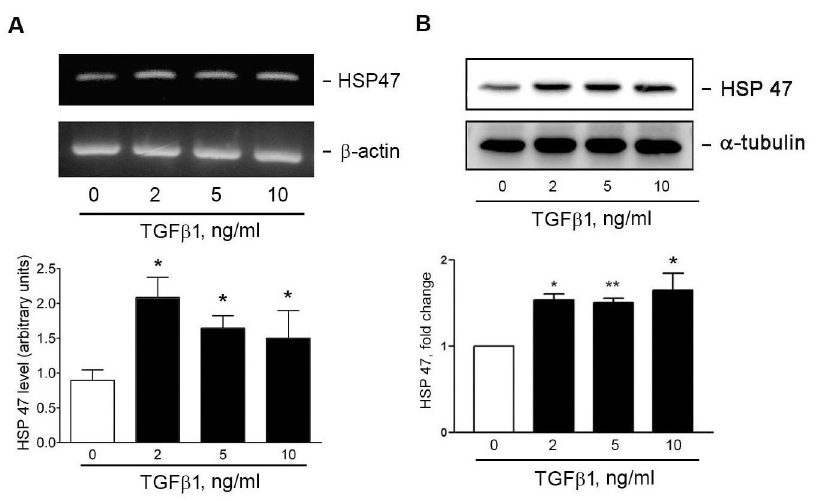
Fig 3. TGF β 1 induces HSP47 expression in HESCs. (A) Cells were treated with vehicle or TGF β 1 for (A) 4 h or (B) 16 h. The HSP47 expression was analyzed through (A) RT-PCR and (B) Western blotting (n = 3). � P < 0.05, and �� P < 0.01 versus vehicle treatment only (basal).